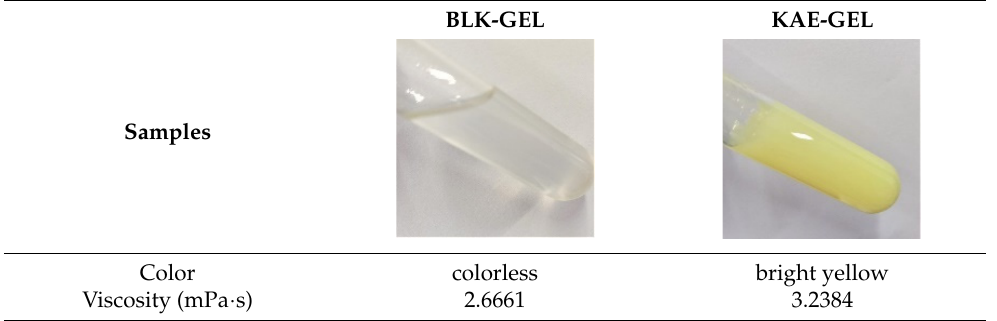
Figure 3. ( A ) Chemical and structural analysis of KAE. ( B ) Formation of KAE-GEL. Table 1. Characteristics of KAE-GEL.